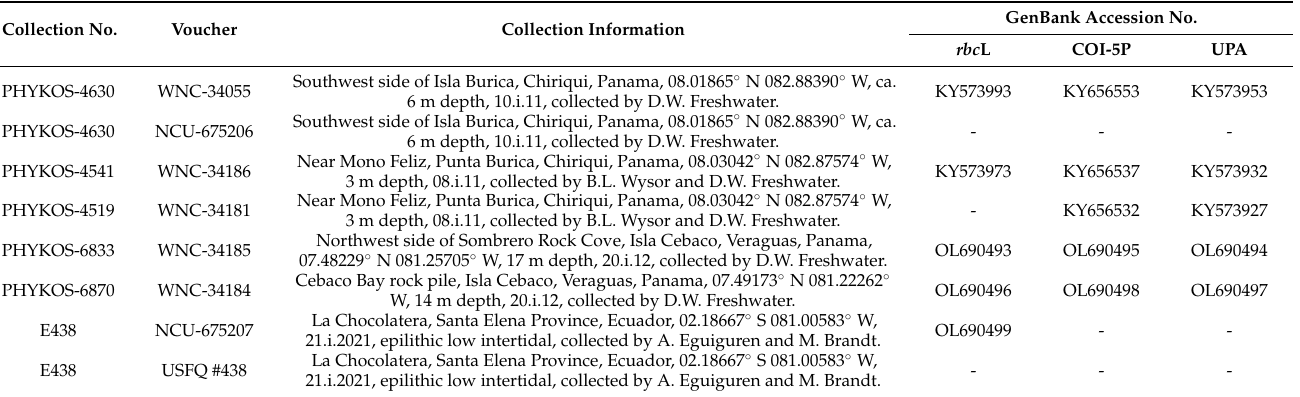
Table 2. Gracilaria parva sp. nov., specimen collection information and GenBank Accession numbers. Collection